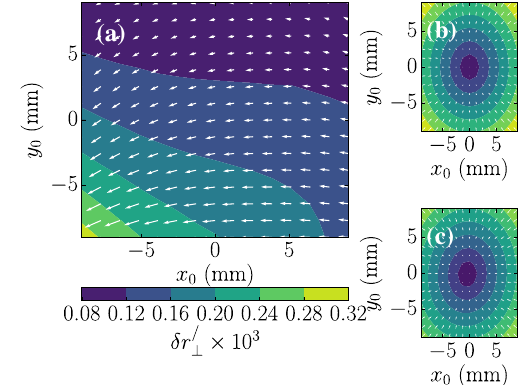
FIG. 2. Transverse momentum magnitude (false color contours) and directions (arrows) simulated downstream of the cavity as a function of initial positions. Plot (a) displays the momentum-kick contribution from the auxiliary couplers only, i.e. δ r 0 ⊥ ≡ 1 δ P − k r ⊥ p ⊥ ; 0 j [see Eqs. (4) and (5)] where δ P ∥ j in longitudinal momentum, while plots (b) and (c) show respec- tively the transverse momentum simulated using the cylindrical- symmetric (b) and the 3-D field map (c) models for the cavity. Plot (a) is obtained as the difference between plots (c) and (b). These simulations were performed for 10-MeV electrons with E 0 ¼ 30 MV = m (corresponding to ϕ ¼ 0 °. Fig. 1(b) is imported in ASTRA where the corresponding transverse electromagnetic fields at given positions ð r; θ ; z Þ are computed assuming an ideal TM 010 mode and under the paraxial approximation as E r ¼ − r i ω r E r ¼ 0 ; z Þ [25]. z ð 2 c 2